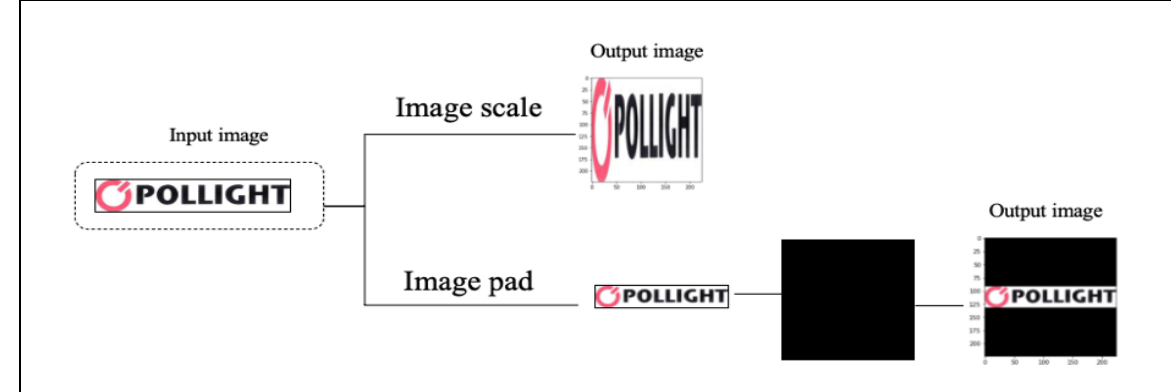
Figure 3. Image scaling and padding.